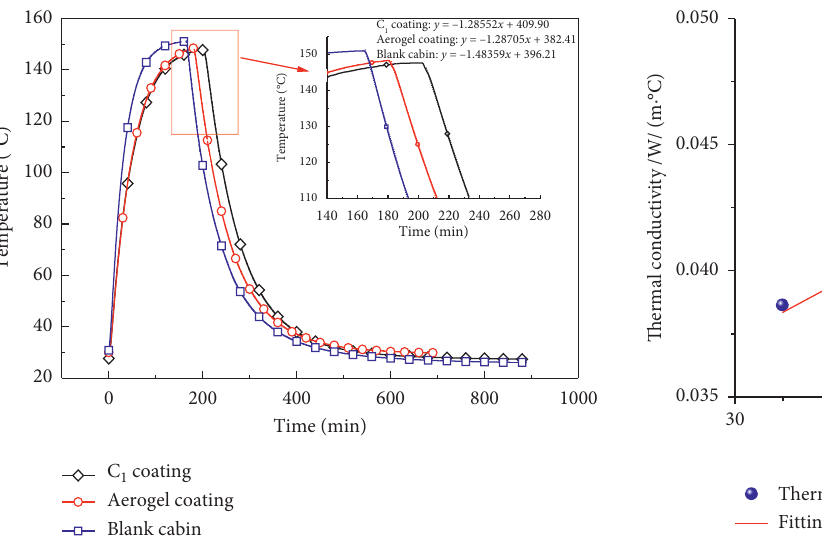
Figure 16: Thermal conductivity of the C